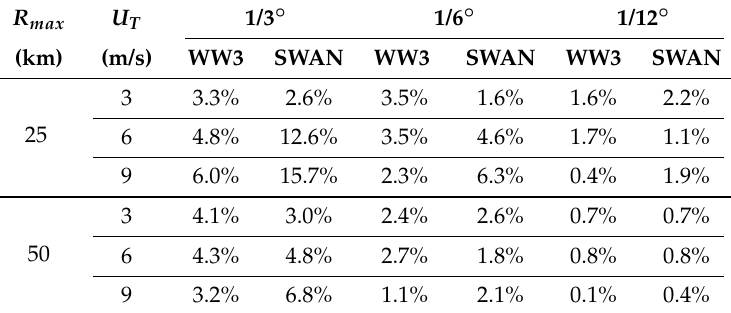
Figure 4. Maximum SWH in time-averaged quasi-steady state wave fields simulated with six different idealized storms, with four different spatial resolutions, and with four different storm propagation directions: ( a ) WW3 results; and ( b ) SWAN results. Dashed lines of different colors represent different directions, with track (I) in blue, track (II) in cyan, track (III) in yellow and track (IV) in red. Asterisk marker denotes the actual data point. Table 4. Largest absolute errors in maximum SWH with different resolutions relative to results with the highest resolution (1/24 ◦